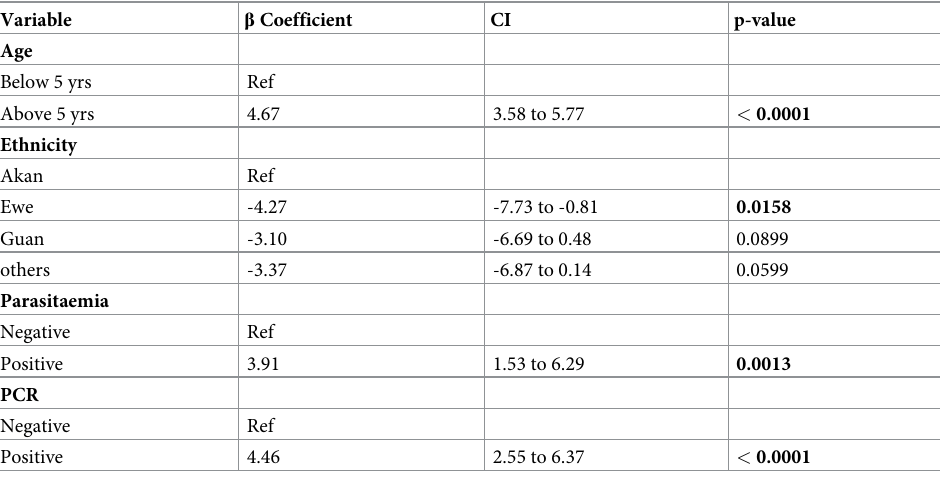
Table 3. Factors associated with antibody breadth score. Variable β Coefficient CI p-value Age Below 5 yrs Ref Above 5 yrs 4.67 3.58 to 5.77 < 0.0001 Ethnicity Akan Ref Ewe -4.27 -7.73 to -0.81 0.0158 Guan -3.10 -6.69 to 0.48 0.0899 others -3.37 -6.87 to 0.14 0.0599 Parasitaemia Negative Ref Positive 3.91 1.53 to 6.29 0.0013 PCR Negative Ref Positive 4.46 2.55 to 6.37 < 0.0001 Multiple linear regression was used to generate coefficient and CI.